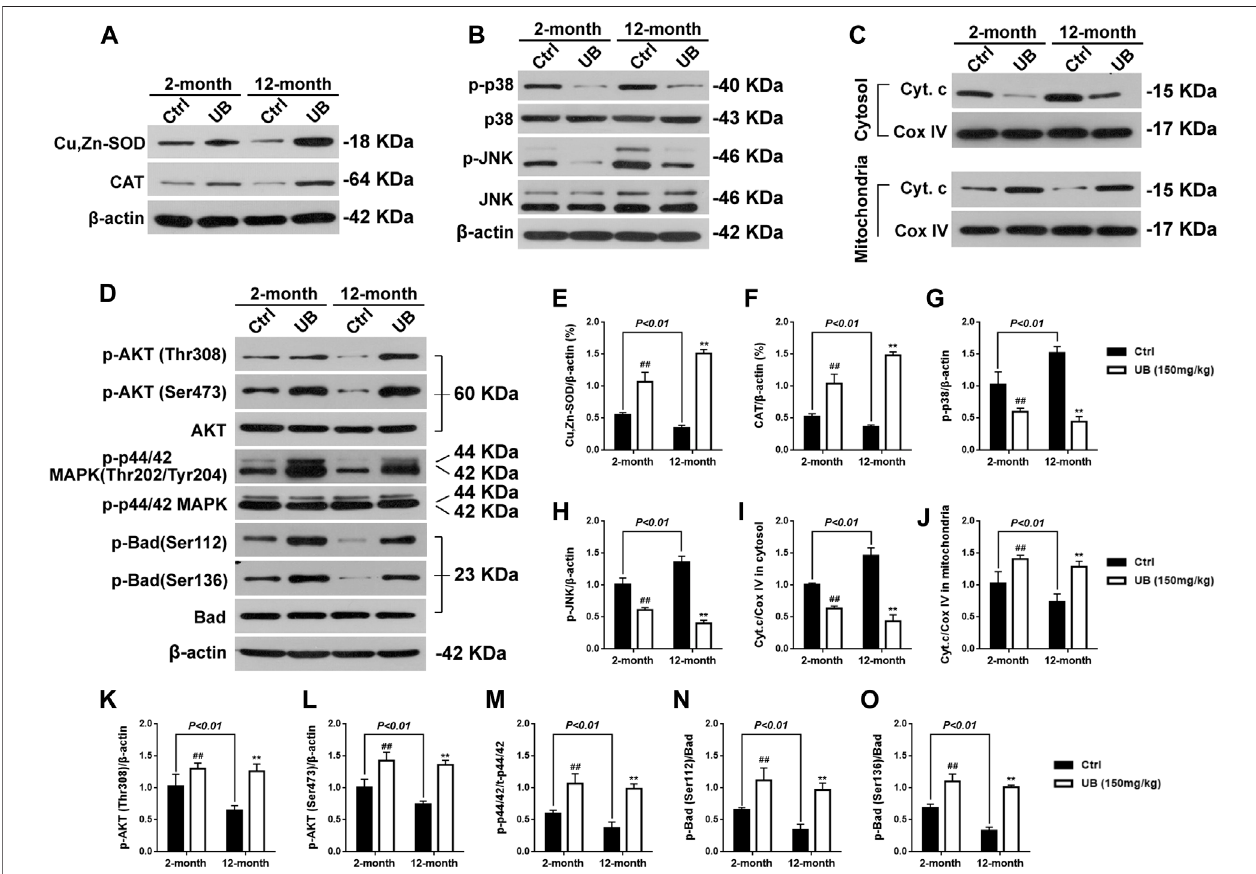
FIGURE 8 | Underlying molecular mechanisms of UB in normal young mice and naturally senile mice. (A) UB enhanced the activity of Cu, Zn-SOD and CAT in hippocampal tissue of 2-months- and 12-months-old mice. (B) UB suppressed the activation of p-JNK and p-p38 in hippocampal tissue of 2-months- and 12-month- oldmice. (C) UBinhibitedthereleaseofCytCfrommitochondriainthebrainsof2-months-and12-month-oldmice. (D) UBfacilitatedthephosphorylationofAkt,p44/42 MAPK and Bad in the brains of 2-months- and 12-months-old mice. Quanti fi cation analysis of Cu, Zn-SOD (E) , CAT (F) , p-p38 (G) , p-JNK (H) , Cyt.c/COX IV in cytosolic (I) andmitochondrial (J) ,p-Akt(Thr308)/Akt (K) ,p-Akt(Ser473)/Akt (L) ,p-p44/42/t-p44/42 (M) ,p-Bad(Ser112)/Bad (N) andp-Bad(Ser136)/Bad (O) . β -actin served asaninternalcontrol( n (cid:1) 6pergroup).Allresultsaredescribedasmeans ± SD. # p < 0.05and ## p < 0.01vsthecontrolgroup;* p < 0.05and** p < 0.01vsthe12- months-old aging